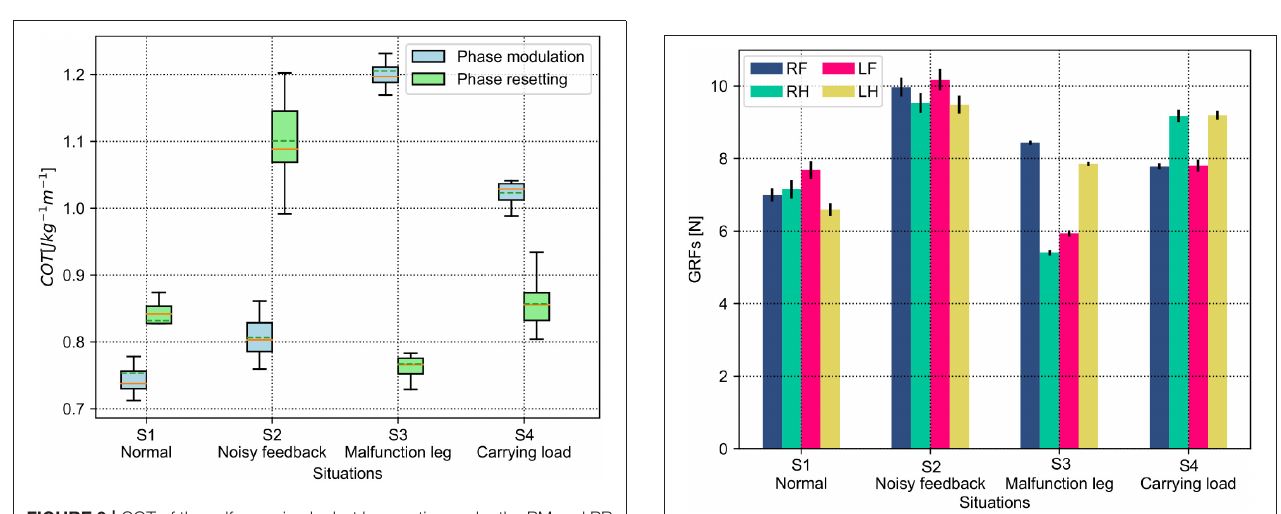
FIGURE 9 | COT of the self-organized robot locomotion under the PM and PR in the four situations. The solid and dashed lines in the boxes indicate the median and mean values of the COT, respectively.